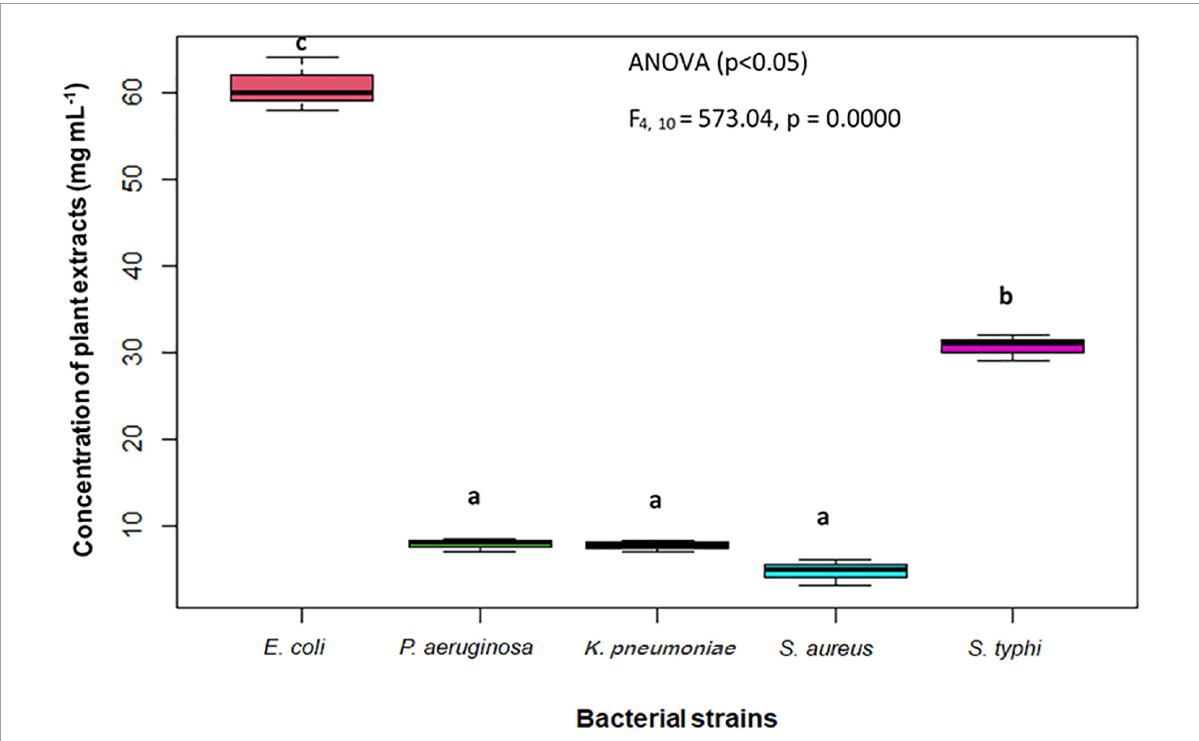
FIGURE8 Minimum inhibitory concentration (MIC) of the most effective plant extract against test organisms. Dissimilar letters (b and c) show significant difference and similar letters (a) show insignificant